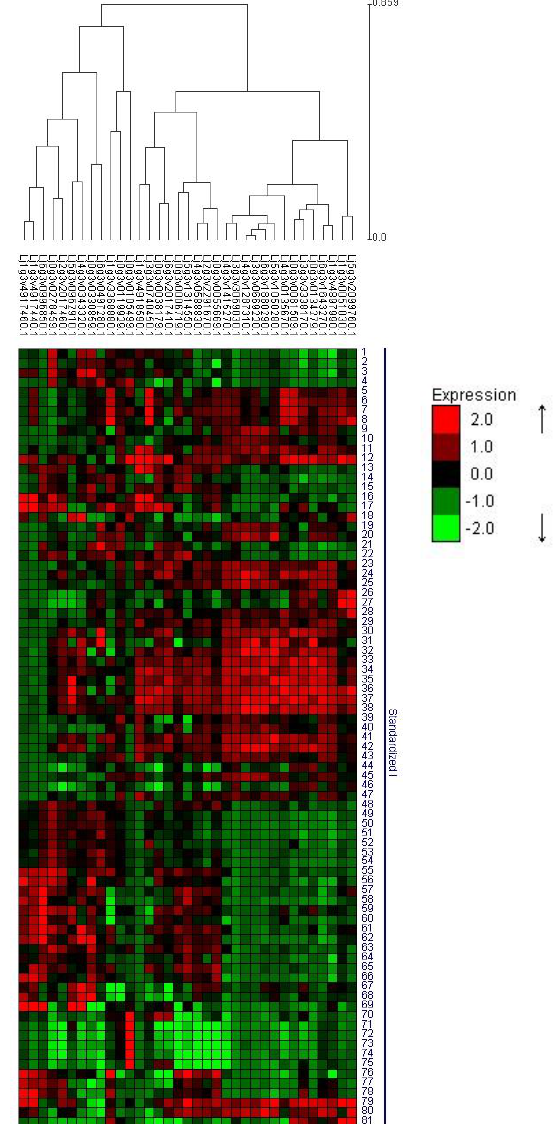
Figure 3. Hierarchical clustering of genes downregulated in Nod roots. The log2 of standardized levels of gene expression is shown for each one of the 81 conditions described in Table S6.